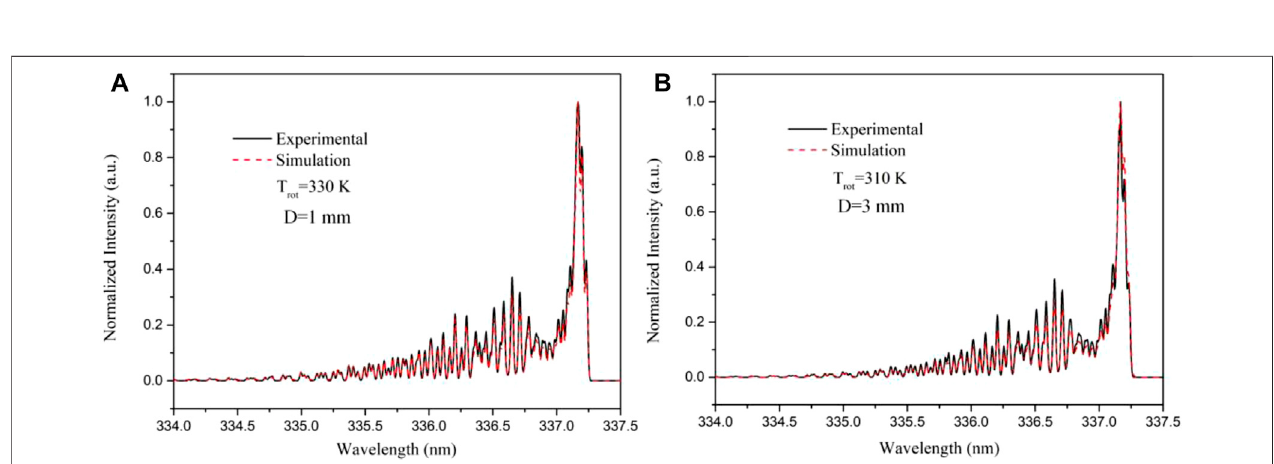
FIGURE10| Opticalemissionspectraofplasmajetsintheafterglowregions.Thedirectionofthejetisparalleltotheslitofthespectrometer.Thedistancebetween the sampling position and the nozzle is 2 mm. (A,B) Optical emission spectrum of plasma jets from 300 to 800 nm, D = 1 mm. (C,D) Optical emission spectrum of plasma jets from 300 to 800 nm, D = 3 mm.